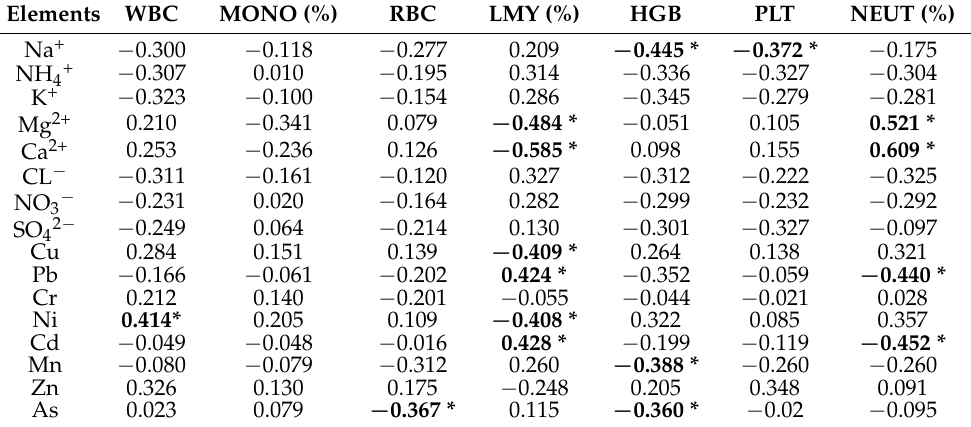
* Bold represent significant correlation at the 0.01 level (both sides). WBC, white blood cell count; MONO (%), monocyte ratio; RBC, red blood cell count; LMY (%), lymphatic ratio; HGB (g/L), hemoglobin; PLT, platelet count; NEUT (%), neutrophil ratio; Na + , sodium ion; NH 4+ , ammonium ion; K + , potassium ion; Mg 2+ , magnesium ion; Ca 2+ , calcium ion; Cl − , chloride ion; NO 3 − , nitrate ion; SO 4 2 − , sulfate ion; Cu, copper; Pb, lead; Cr, chromium; Ni, nickel; Cd, cadmium; Mn, manganese; Zn, zinc; As,